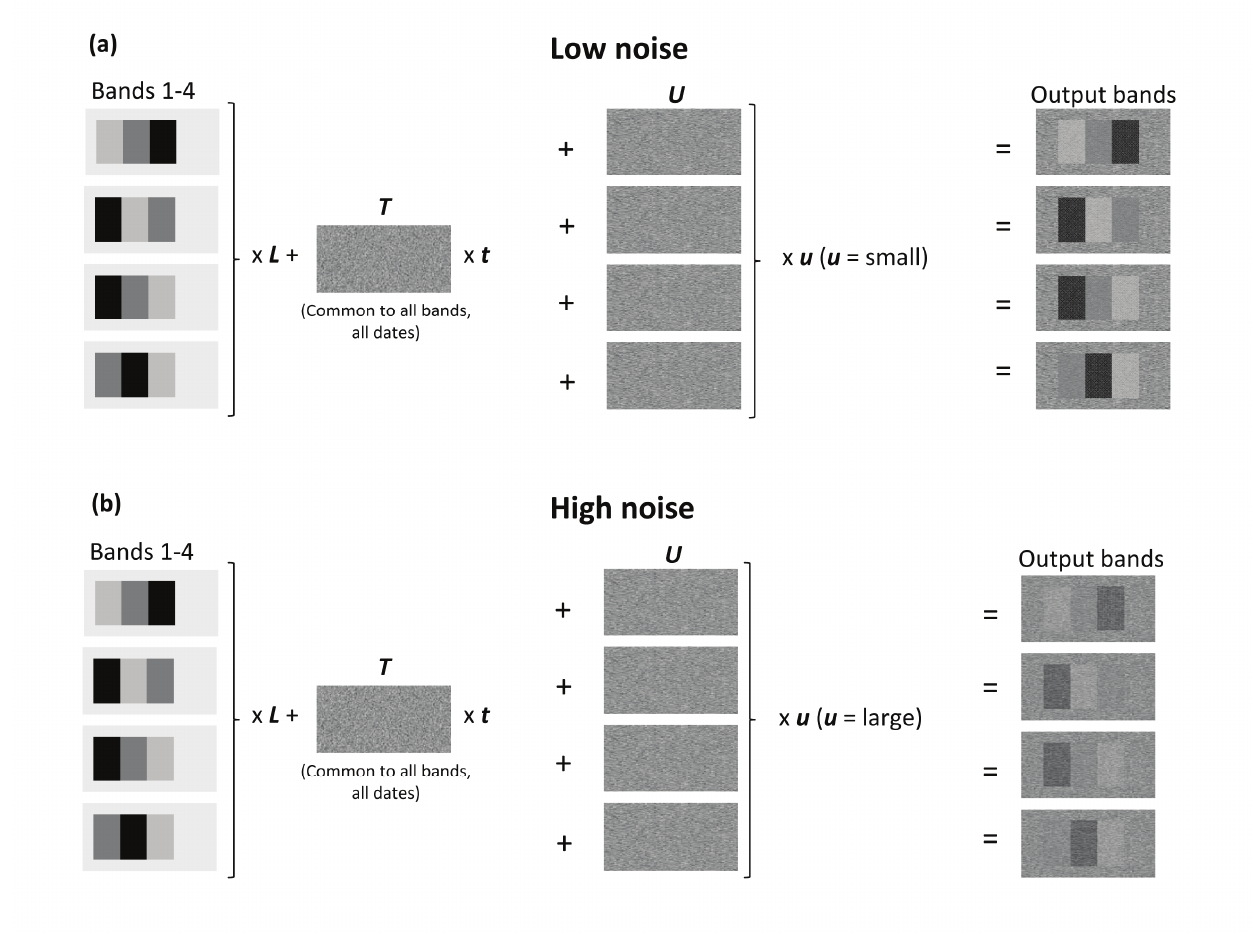
Figure 3. Overview of the construction of simulated data for a range of class separability through adjustments in band variability (noise). (a) Low noise. (b) High